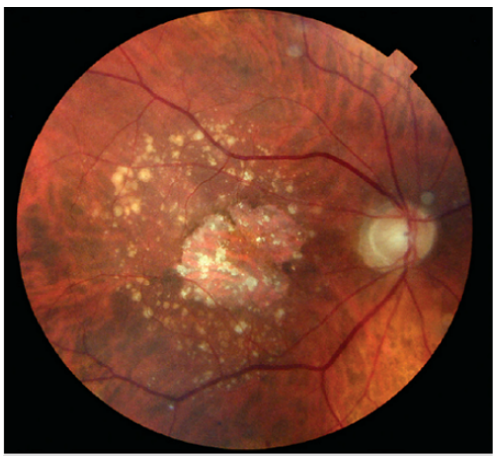
Figure 5. Age-Related Macular